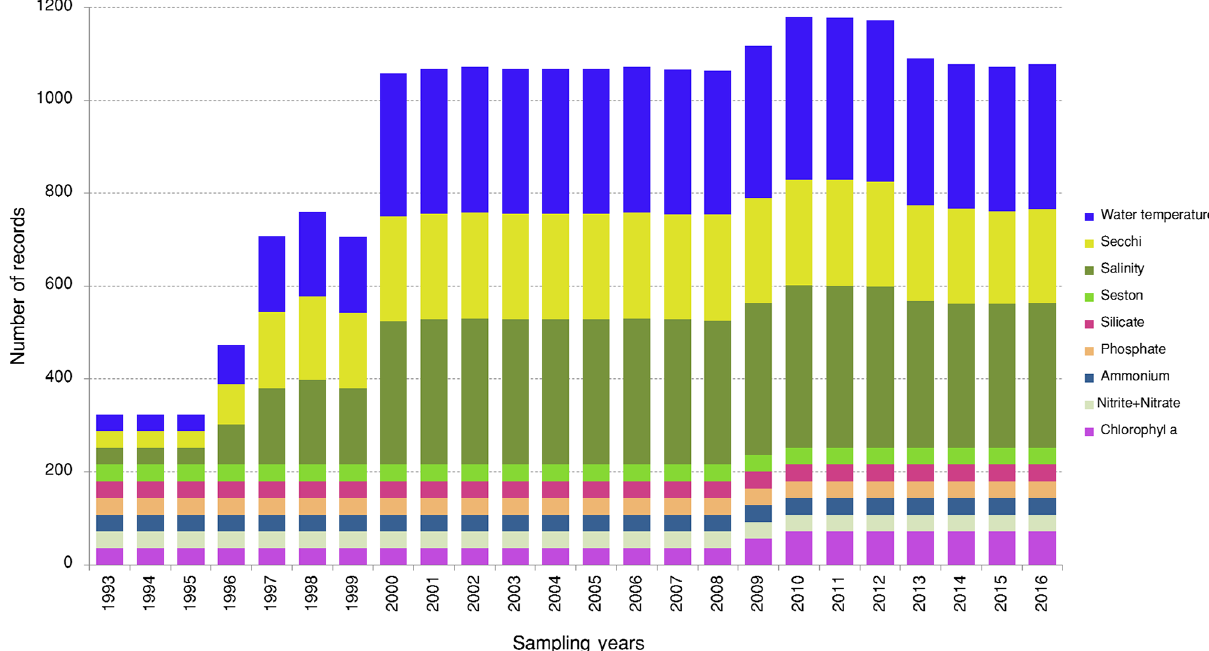
Figure 5. Abiotic records from the LTER-PLEA’s database. Sampling events to measure water salinity, water temperature, water trans- parency, suspended particulate matter, chlorophyll a , and dissolved inorganic nutrients in Patos Lagoon estuary and adjacent marine coast from 1993 to